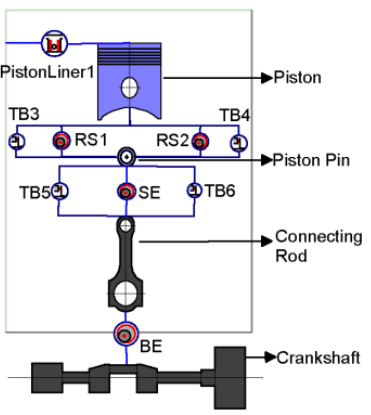
Figure 3. Dynamic model of the test rig.